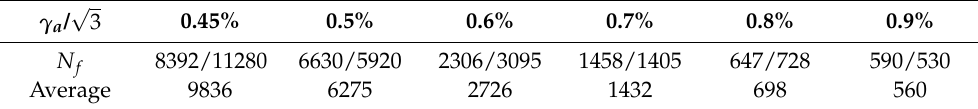
Table 2. The test torsional fatigue life of 30CrMnSiNi2A with γ a /